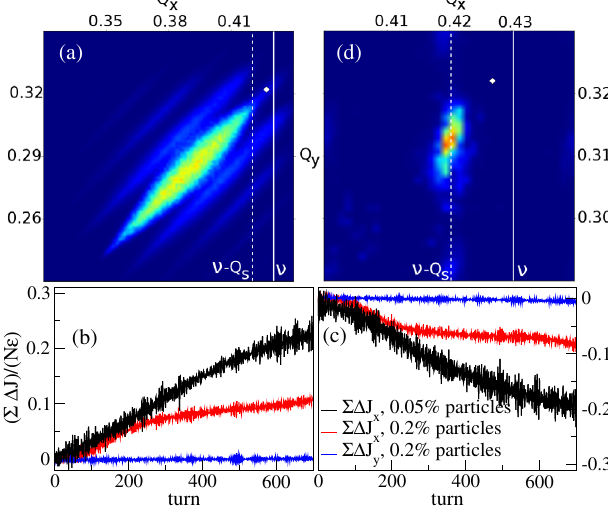
¼ s FIG. 2. (a) Bunch tune footprint at off-resonance for q ¼ 7 . 94 . The white dot corresponds to the bare betatron tunes. same as (b) but for the largest decreasing energy particles.